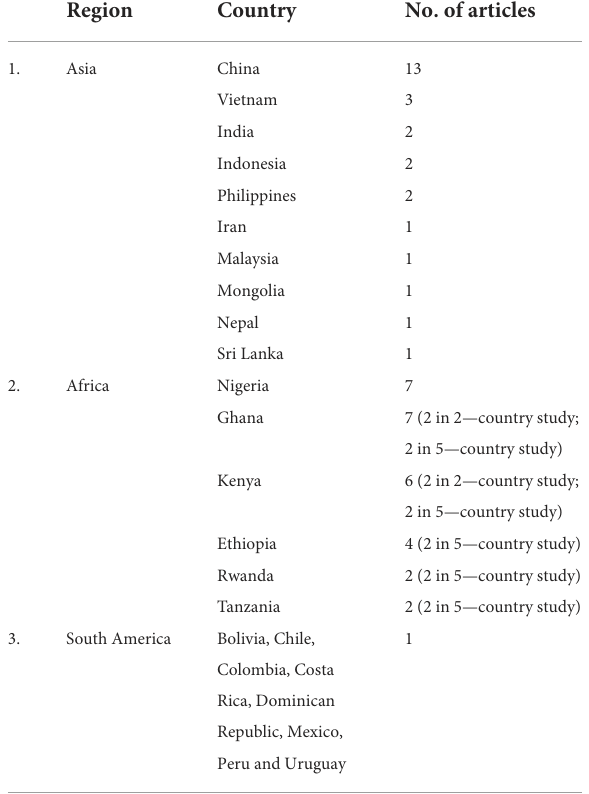
TABLE 2 Location/setting of articles by countries.